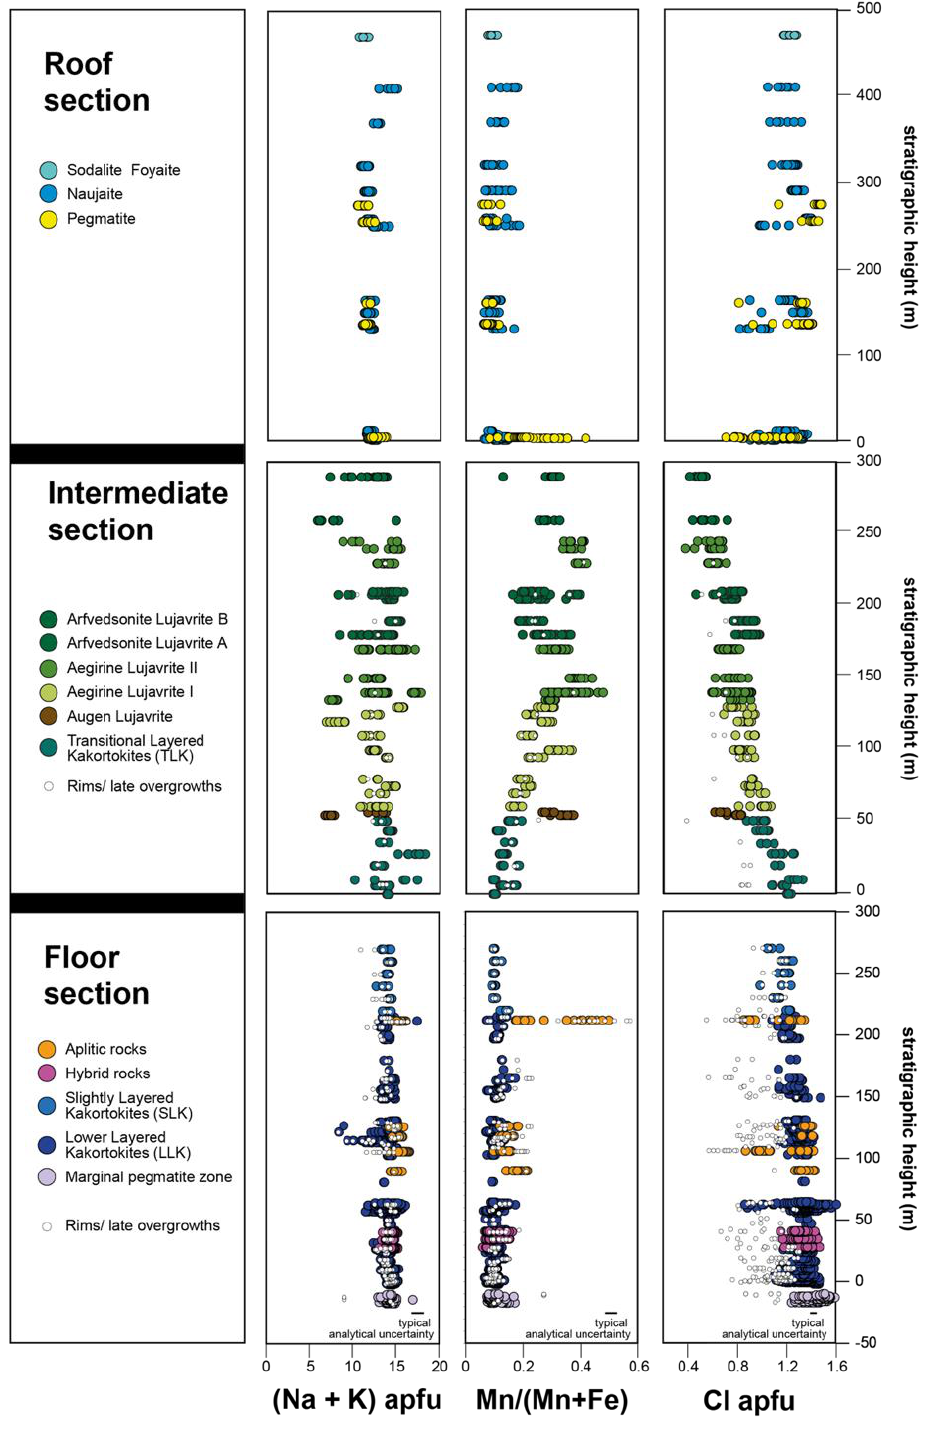
Figure 4. Compositional variation of eudialyte-group minerals (EGM) across the three major stratigraphic sections of the Ilímaussaq Complex, south Greenland expressed as (Na + K) apfu, Mn(Mn + Fe) and Cl apfu.